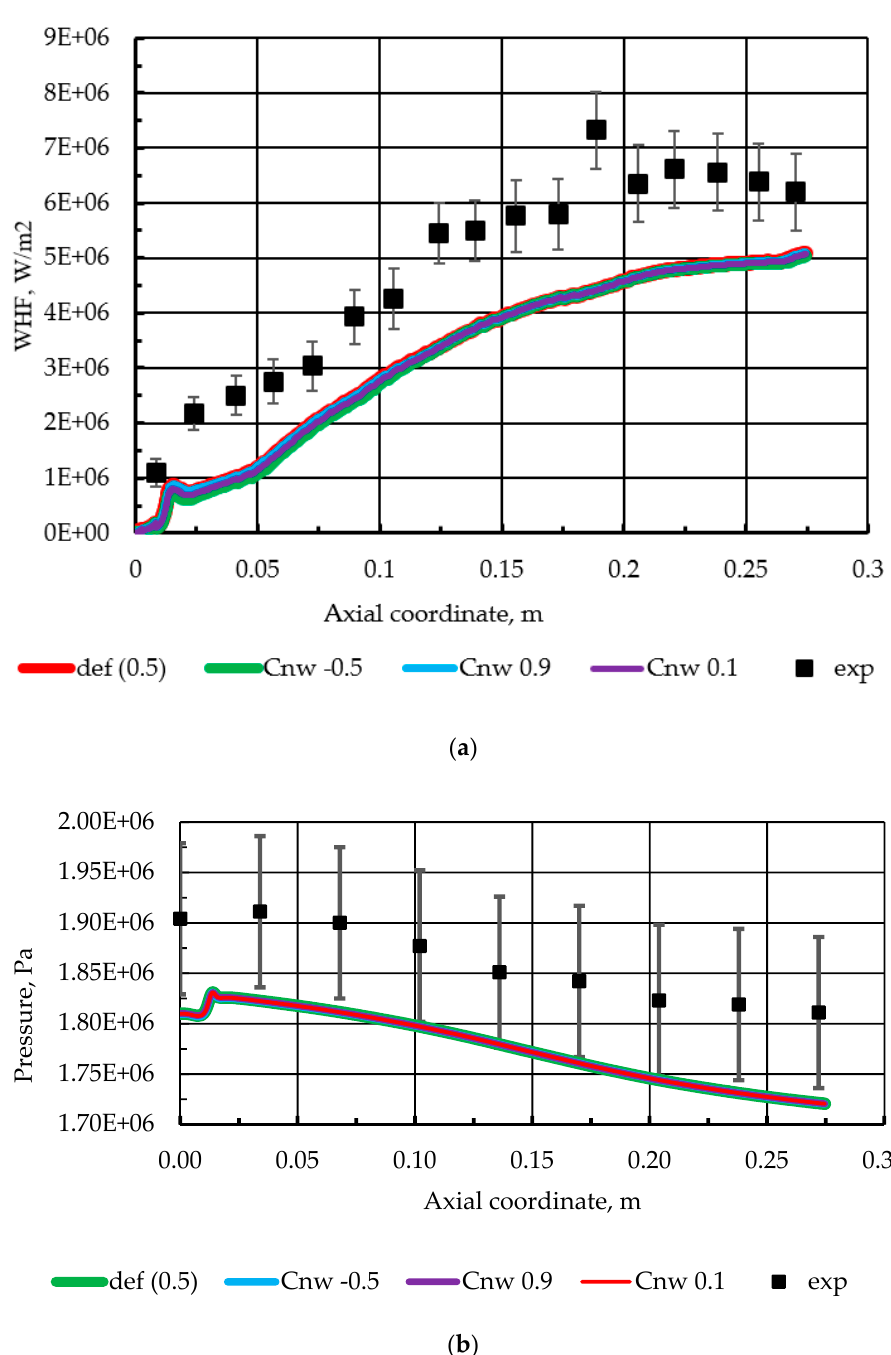
Figure 4. ( a ) Effect of Cnw on wall heat flux; ( b ) Effect of Cnw on pressure.